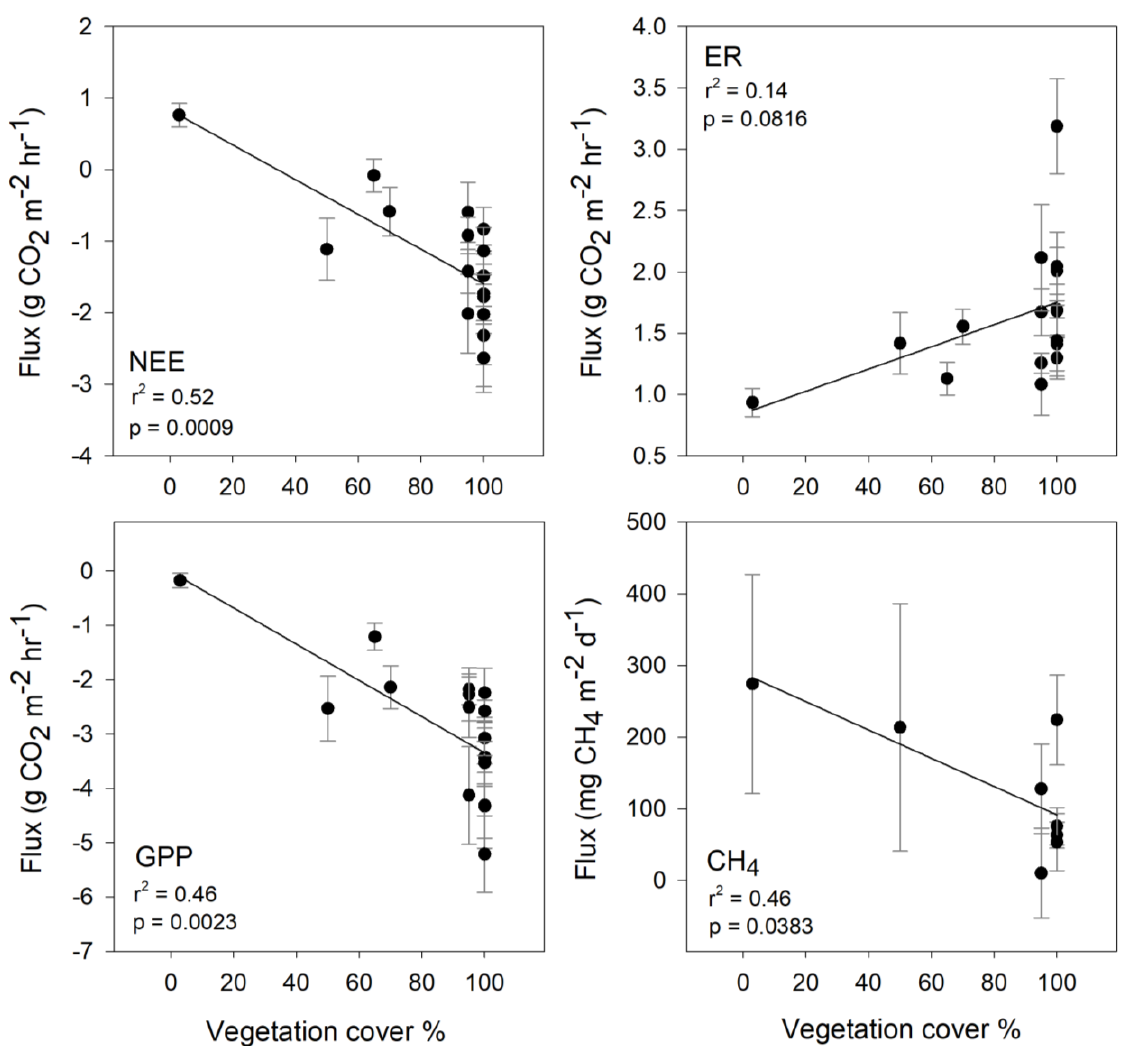
Figure 5. Mean net ecosystem exchange (NEE), ecosystem respiration (ER), gross primary production (GPP), and methane (CH ) flux by percent vegetation cover at Antisana. Error bars indicate one standard 4 error. For carbon dioxide (CO ) components (g CO m -2 hr -1 ), negative values represent uptake by the 2 2 ecosystem. For CH (mg CH m -2 hr -1 ), positive values represent loss from the ecosystem. CH 4 4 shown only for lawns. Linear fit for all graphs. Normality assumption not met for